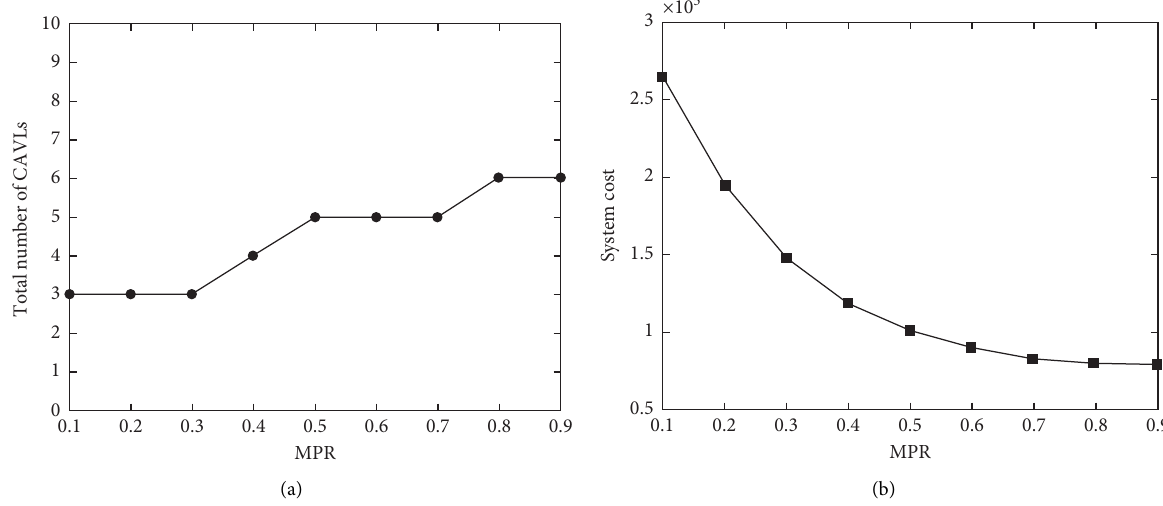
Figure 4: Sensitivity analysis of the CAV MPR. (a) The total number of CAVLs. (b) System